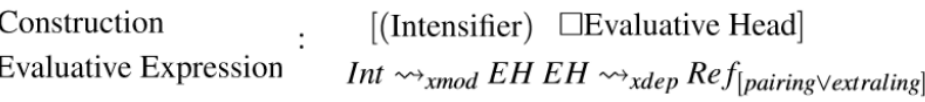
Figure 3. Characterization of the universal construction of evaluative